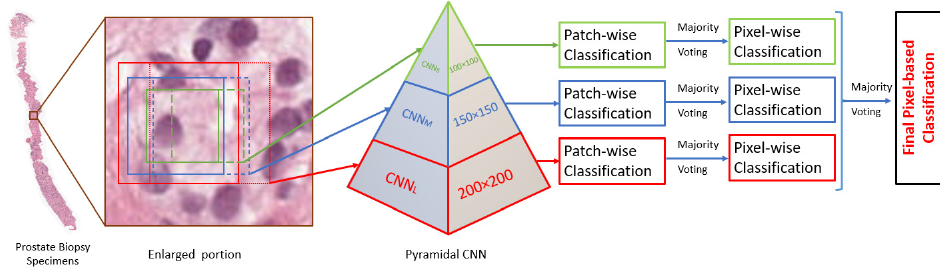
Figure 2. The proposed pipeline for our CAD